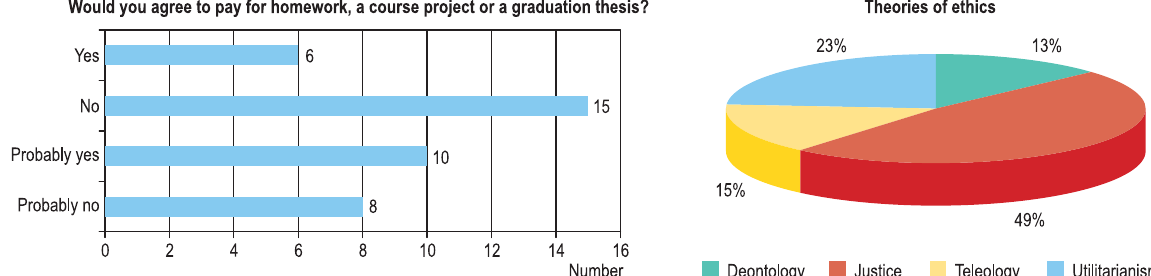
Fig. 4. Payme nt for homework, a course project or a graduation thesis ( on the left ) and theories of ethics selected by the students ( on the right